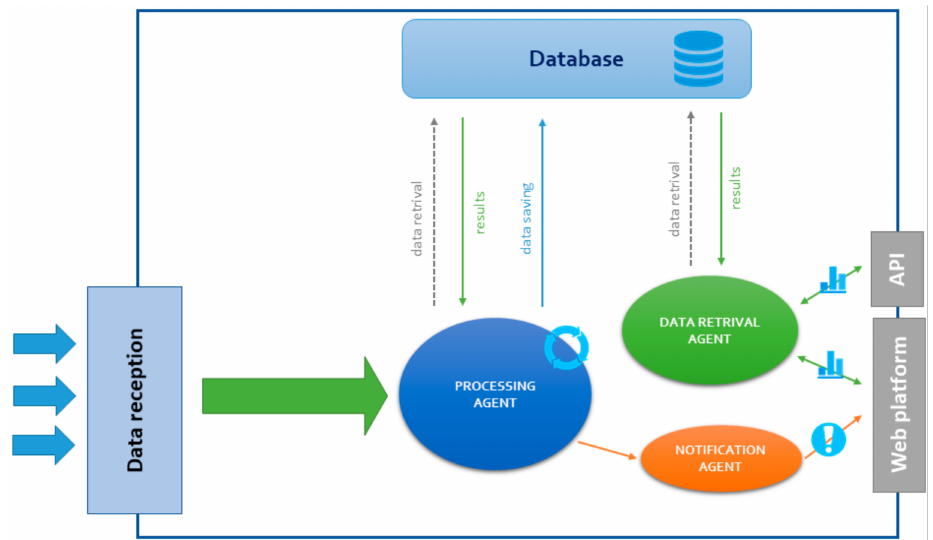
Figure 4. Management and analysis